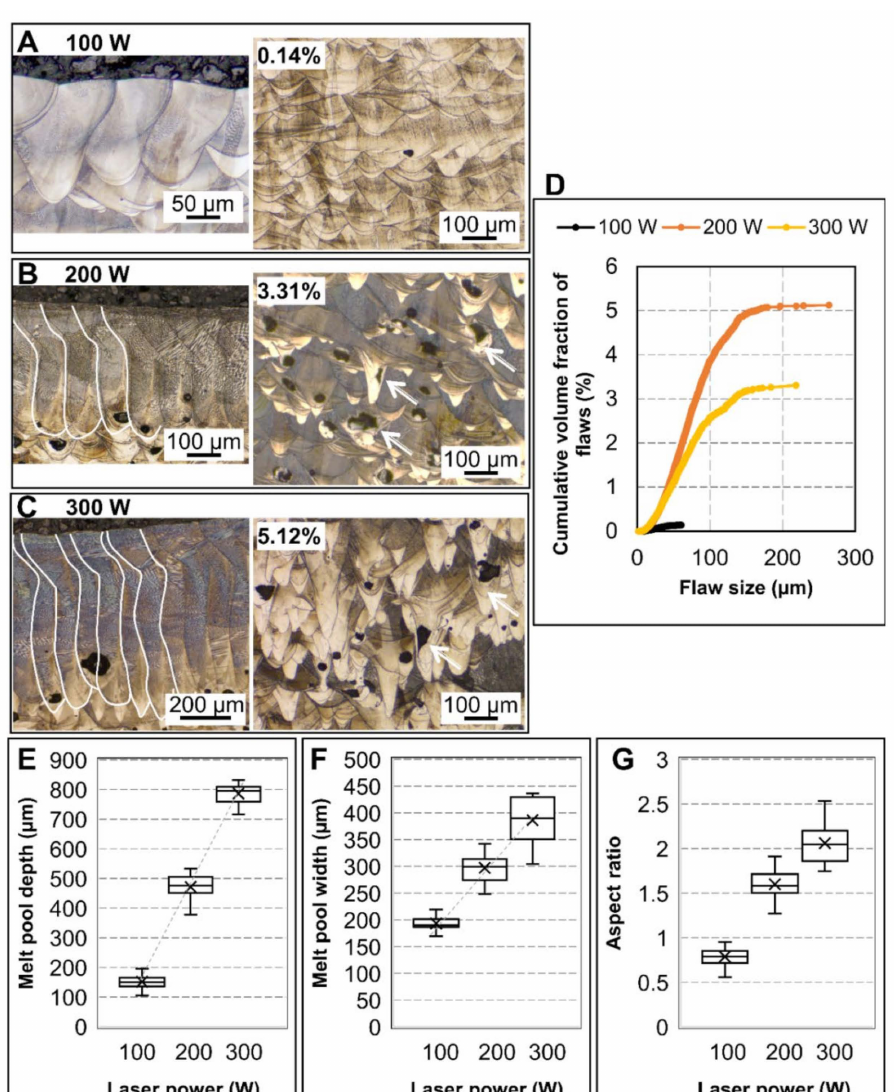
Figure 4. Influence of laser power on melt pool geometries and flaw populations in the keyhole regime. Microstructure of specimens manufactured with laser power of: 100 W ( A ); 200 W ( B ); 300 W ( C ); otherwise identical parameters (nominal laser scan speed 200 mm/s and layer thickness 40 µ m). The volume fraction of flaws is indicated. Melt pool boundaries are highlighted for easier visualization. Arrows indicate keyhole porosity of irregular morphology. ( D ) Corresponding flaw size distributions. Influence of laser power on melt pool: depths ( E ); widths ( F ); aspect ratios ( G